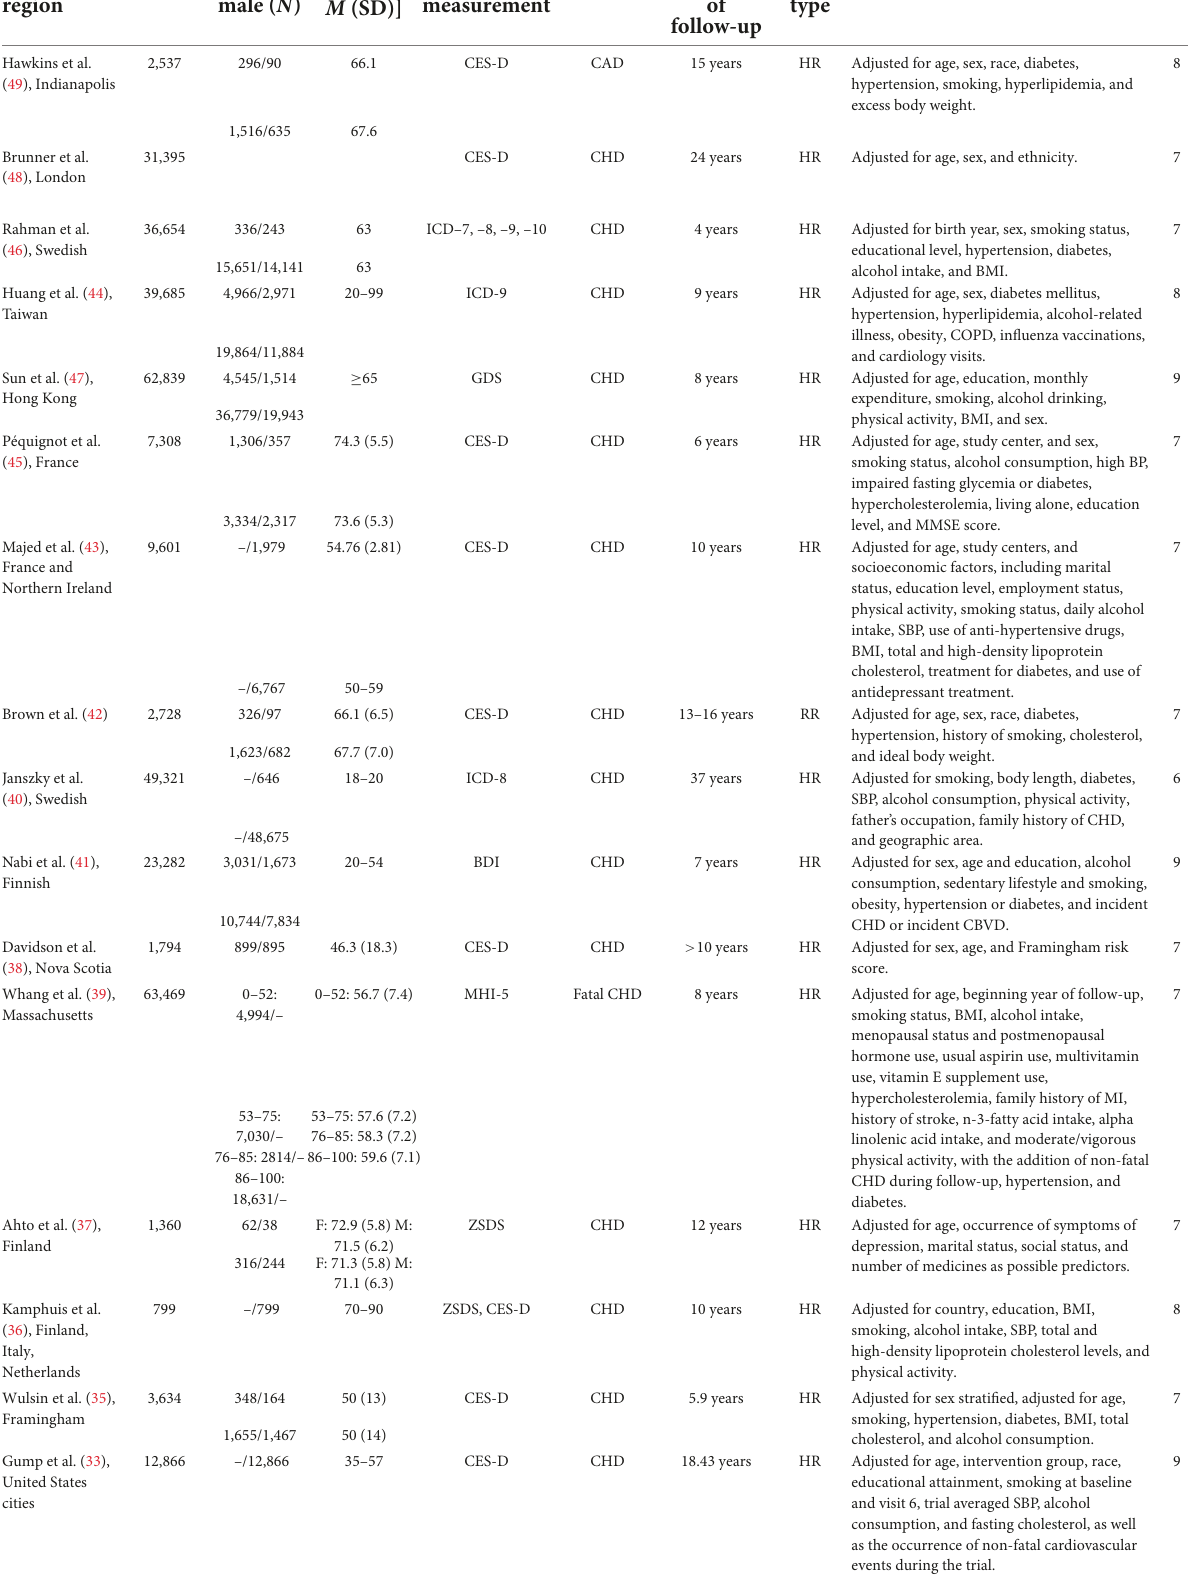
TABLE 1 Characteristics of studies included in the meta-analysis. Risk Adjustment variables References, Sample Female/ Age [years, Depression Outcome Duration type region male ( N ) measurement of M (SD)] follow-up